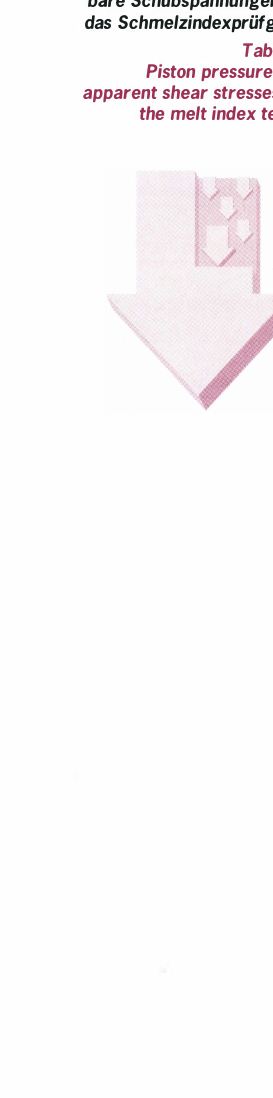
Tabelle 1: Ko/bendriicke und schein­ bare Schubspannungen fur das Schmelzindexpriifgeriit Table 1: Piston pressure and apparent shear stresses for the melt index tester